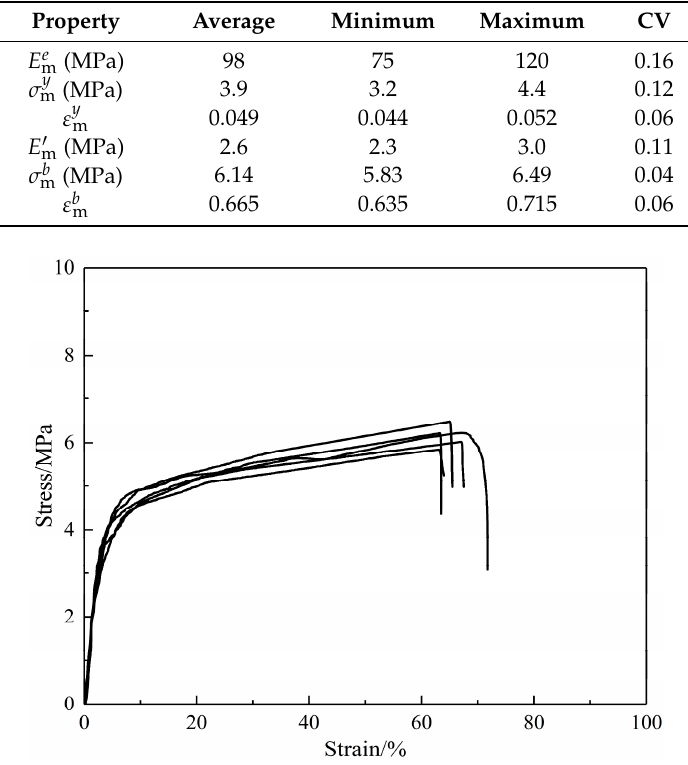
Figure 8. Stress-strain curves of SF/PCL nanofibrous mats. Table 2 . Mechanical properties of SF/PCL nanofibrous mats.